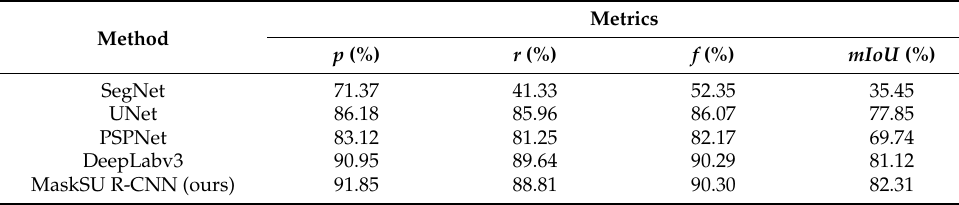
Table 4. Comparison results between different segmentation models.